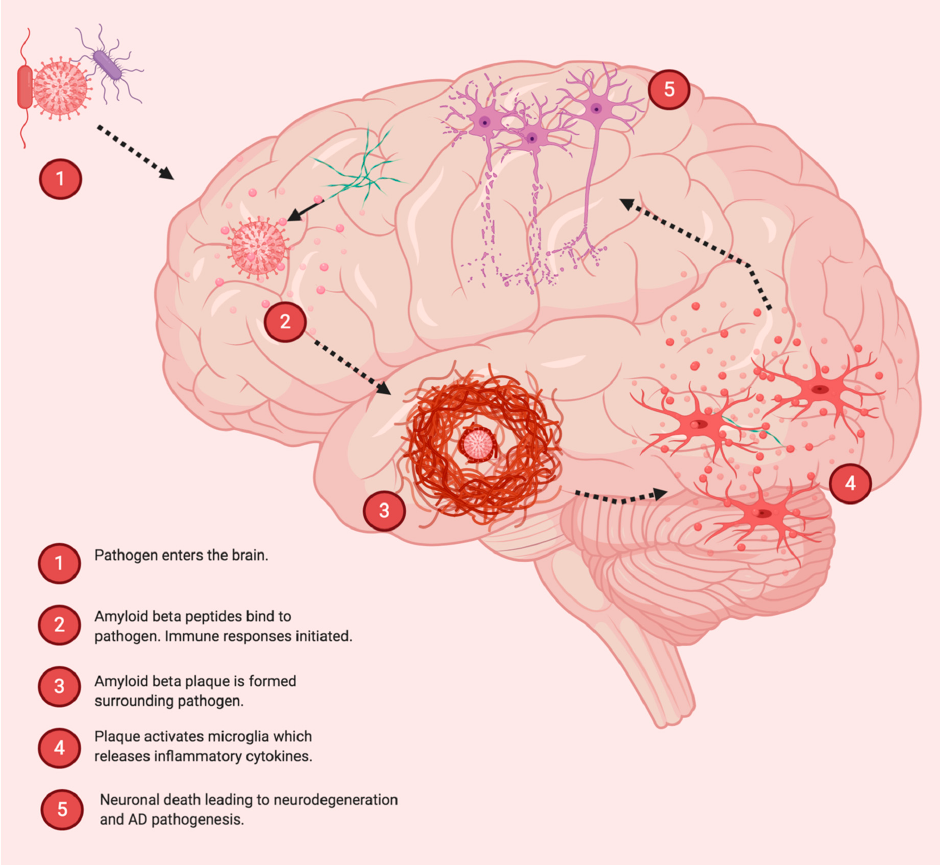
Figure 1. Involvement of Pathogens in Alzheimer’s disease (AD). Pathogens such as viruses